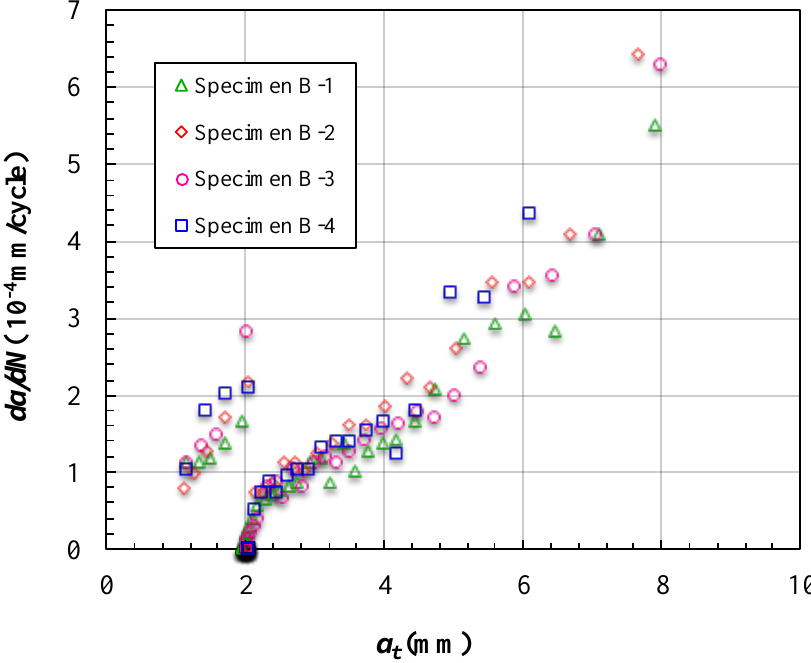
Figure 17. FCG rate at different crack lengths a t of specimens of Group B.